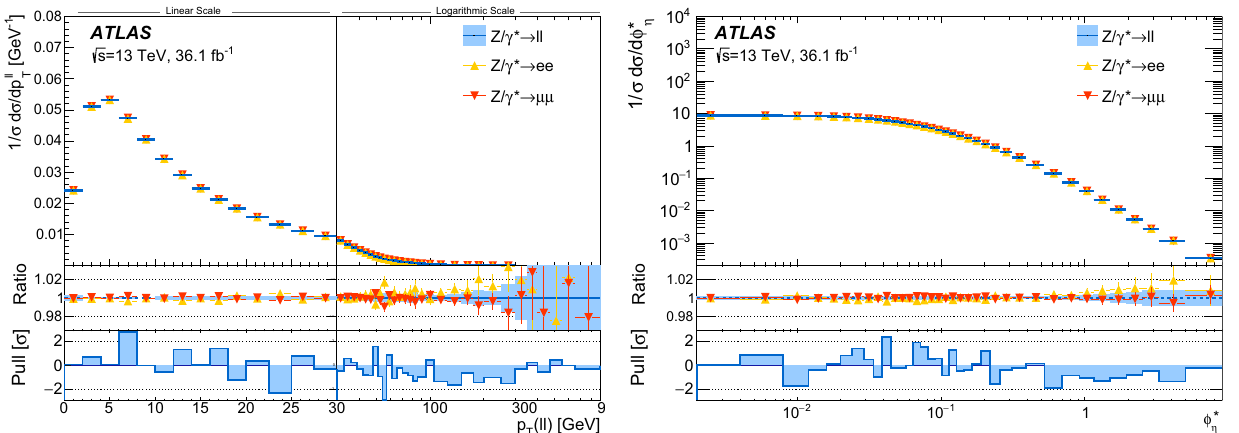
Fig. 4 The measured normalized cross section as a function of p (cid:3)(cid:3) (left) and φ ∗ η (right) for the electron and muon channels and the com- bined result as well as their ratio together with the total uncertainties, shown as a blue band. The pull distribution between the electron and